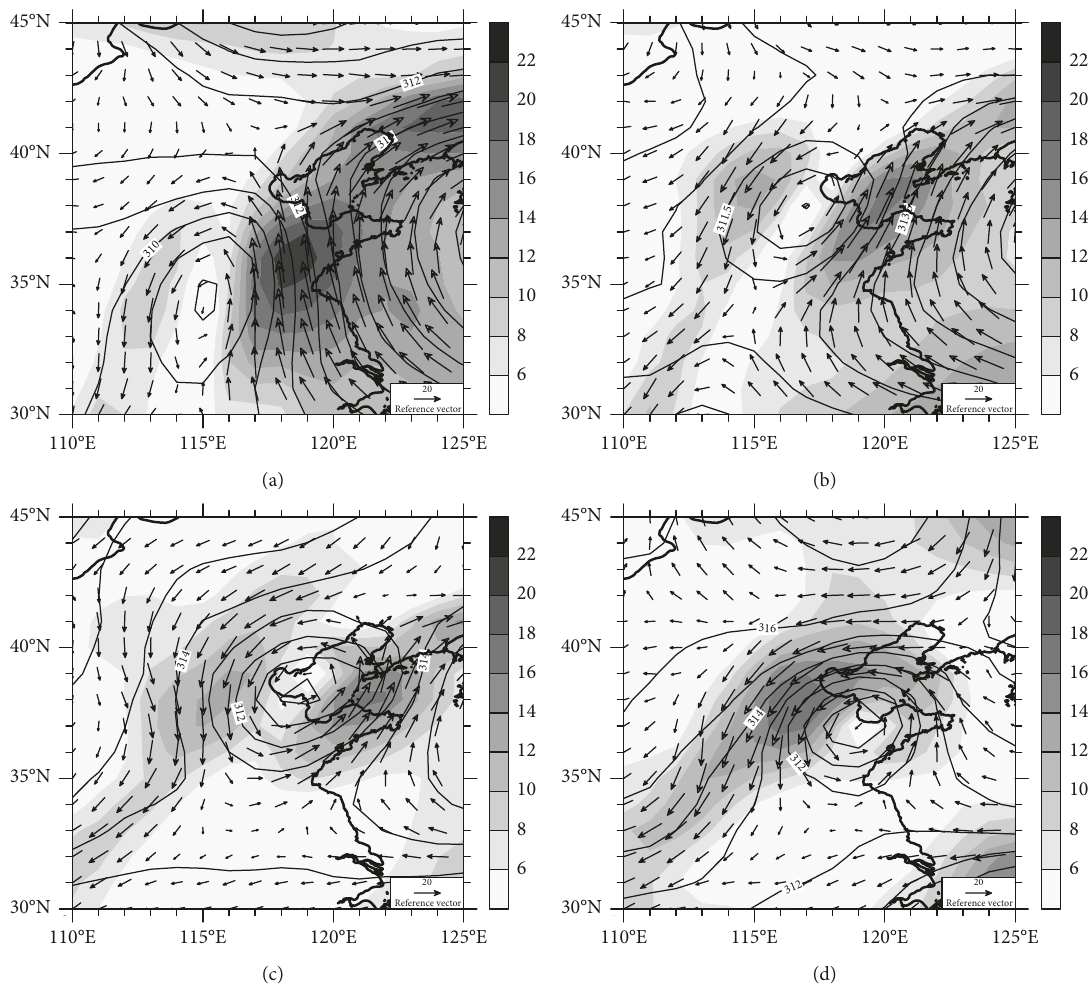
Figure 8: 700hPa circulation patterns: (a) 0000 UTC 14 August; (b) 1200 UTC 14 August; (c) 0000 UTC 15 August; (d) 1200 UTC 15 August. The contours represent the GPH (gpm), the vectors represent the winds at 700hPa, and the shading represents the wind speed